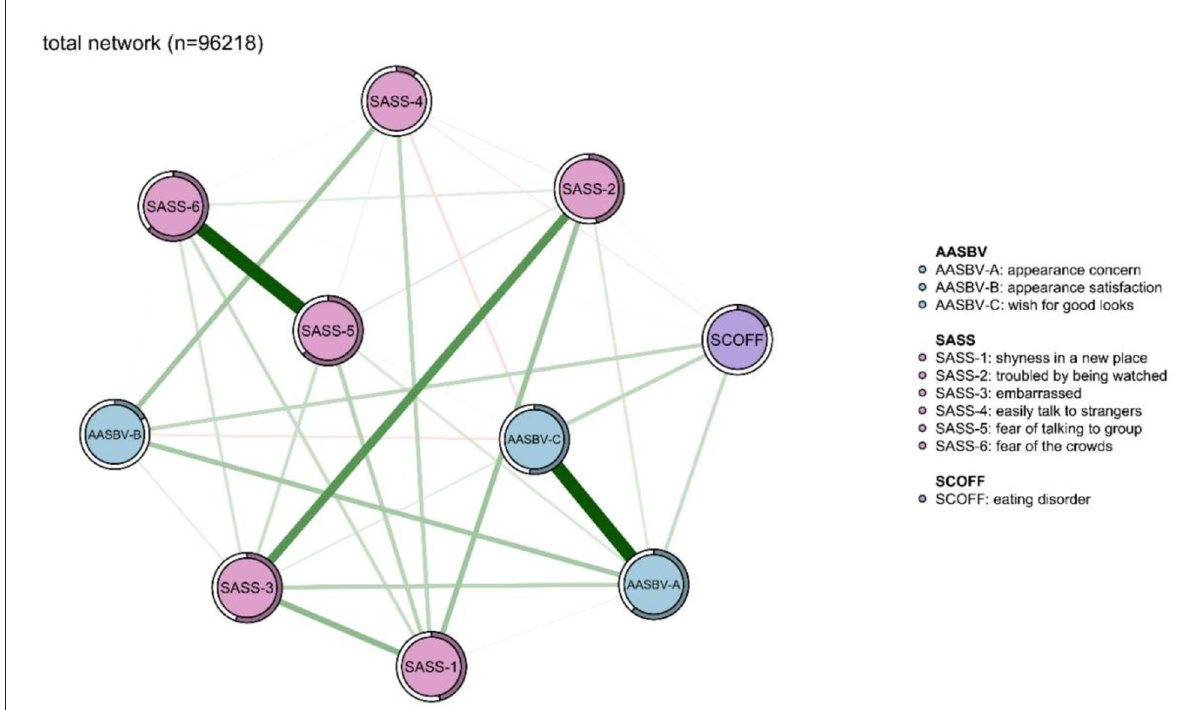
FIGURE1 Network analysis between symptoms of eating disorder, appearance anxiety, and social anxiety in the total sample ( n = 96,218). The thickness of the edges indicates the magnitude of the association. Green edges referred to positive associations, while red edges showed negative ones. The circle around the item represents the amount of